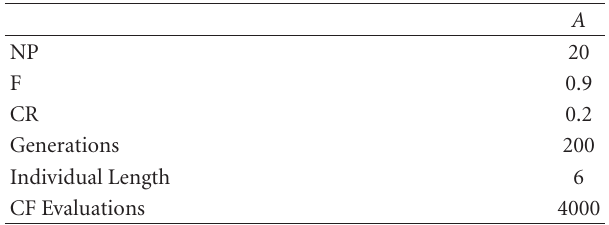
Table 7: The best values of optimized parameters by GA, SA.